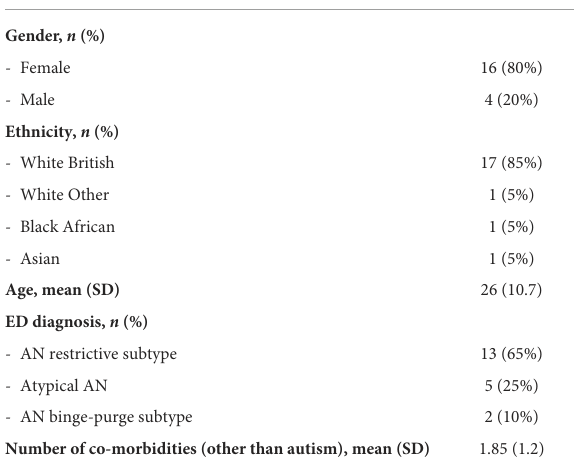
TABLE 1 Summary of demographic